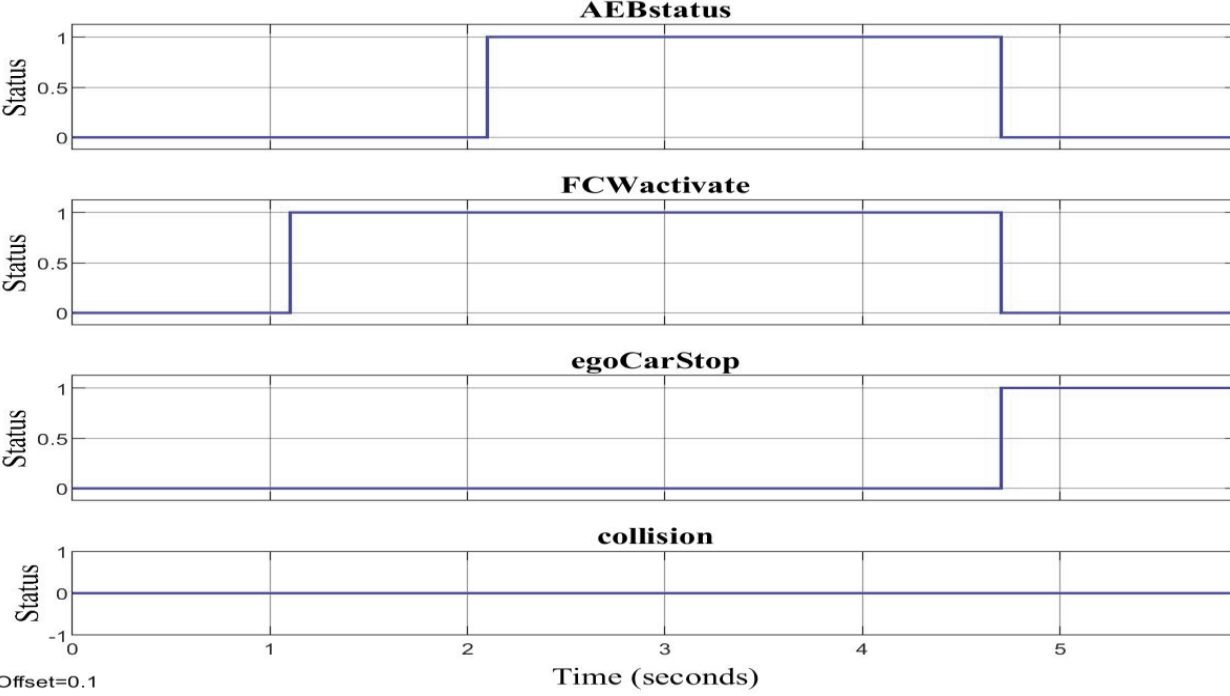
Figure 16. Status of AEB, FCW, ego car stop, and collision at the normal scenario.